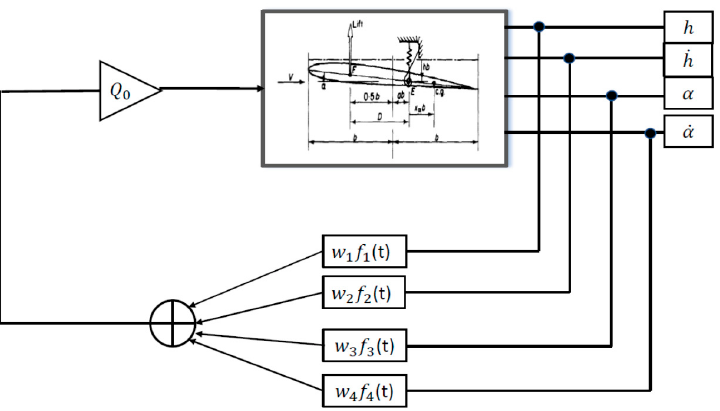
Figure 4. Schematic of closed-loop harmonic parametric excitation.